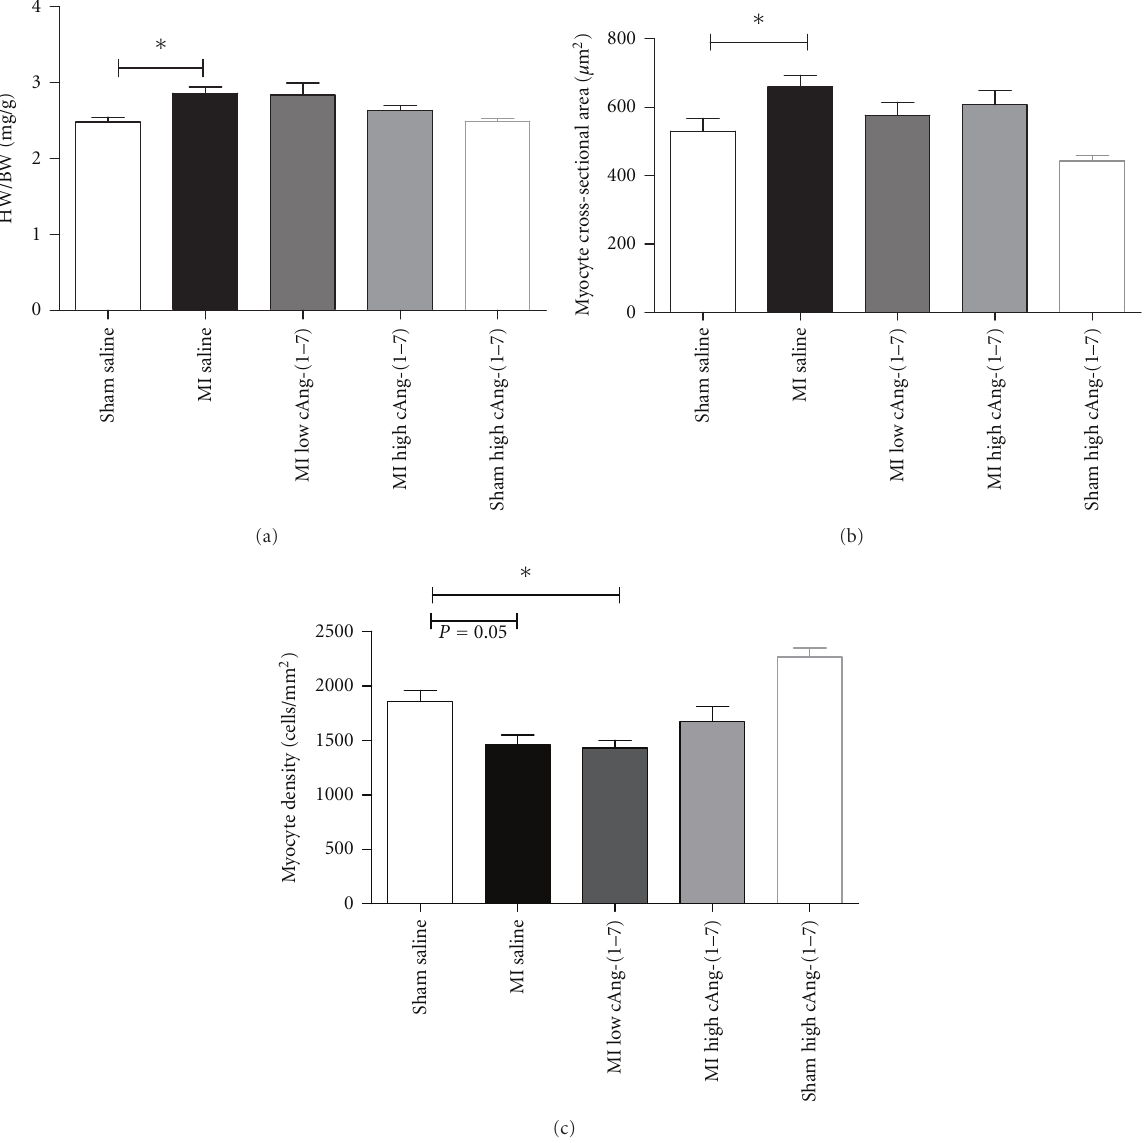
Figure 1: Comparison of heart weight/body weight ratios between the di ff erent treatments (a), variables of cardiac hypertrophy: myocyte, cross-sectional area (b), and myocyte density (c). ( ∗ P < 0 . 05, One way ANOVA, Dunnett’s post hoc